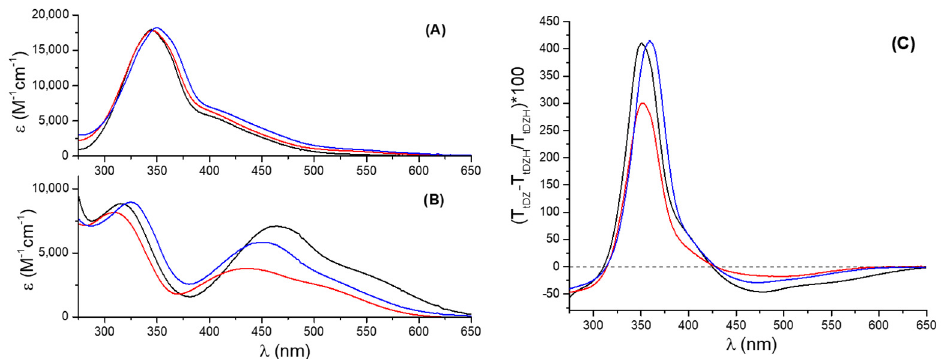
Figure 2. Absorption spectra of t -DZH in ( A ) and t -DZ in ( B ) recorded in acetonitrile (black trace), water/acetonitrile = 1/1 (red trace), and in the aqueous micellar solution of SB3-14 (blue trace). Graph ( C ) reports the relative percentage transmittance changes induced by the deprotonation in the three media: acetonitrile (black trace), water/acetonitrile = 1/1 (red trace), and in the aqueous micellar so- lution of SB3-14 (blue trace).